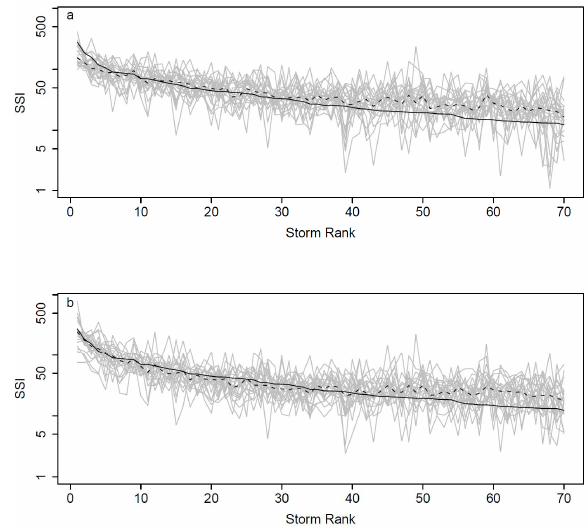
Fig. 3 Storm severity Index (SSI) for a) variance-unadjusted and b) variance-adjusted windfields. Solid line is for the historical storms. Grey lines are the 22 individual RCMs with their median (dashed).